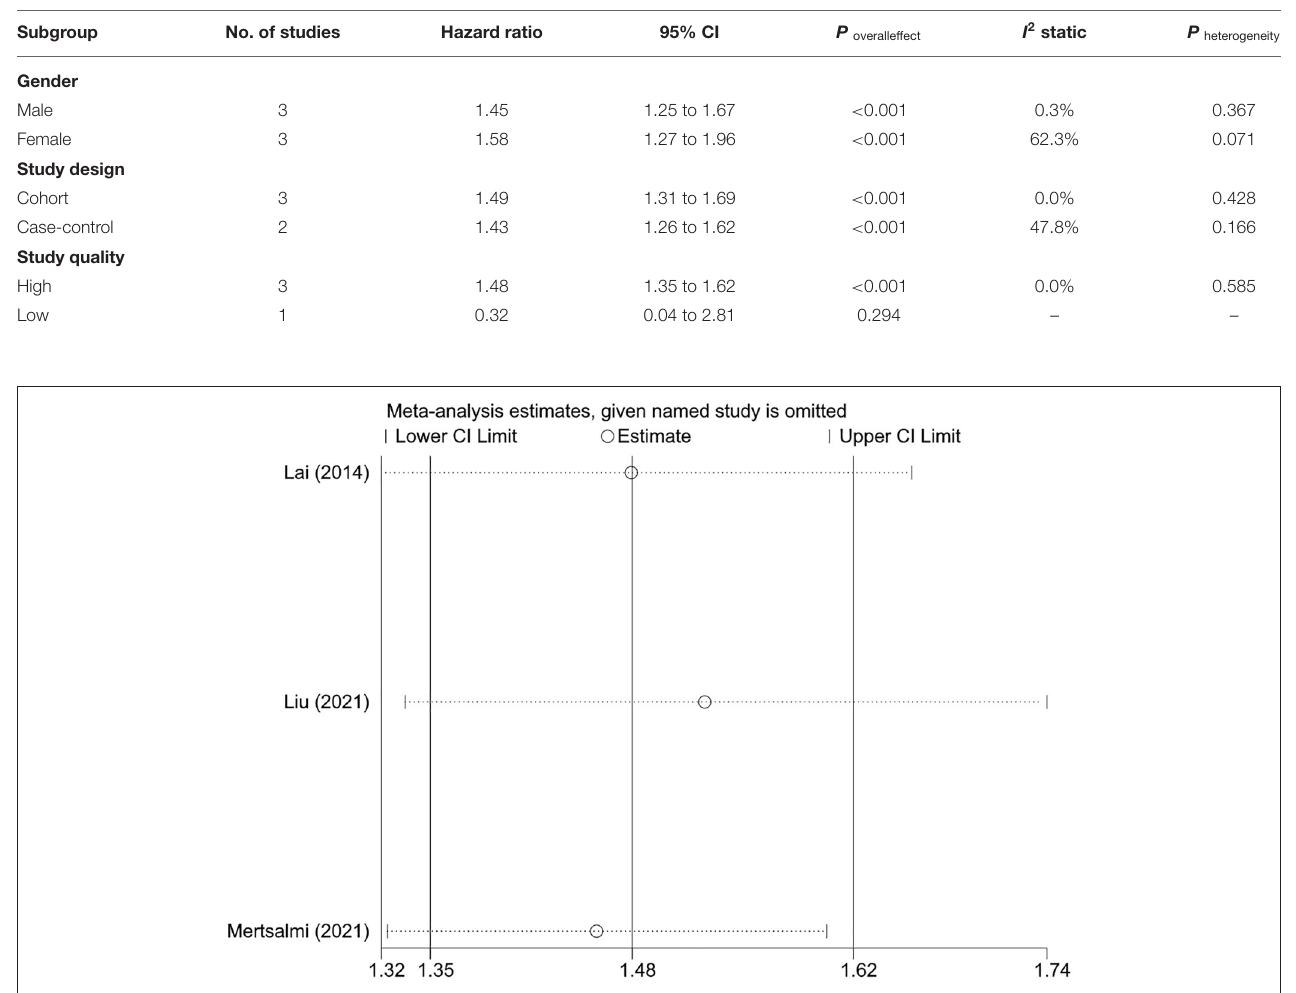
FIGURE 3 | The sensitivity analysis of the associations between irritable bowel syndrome and risks of Parkinson’s